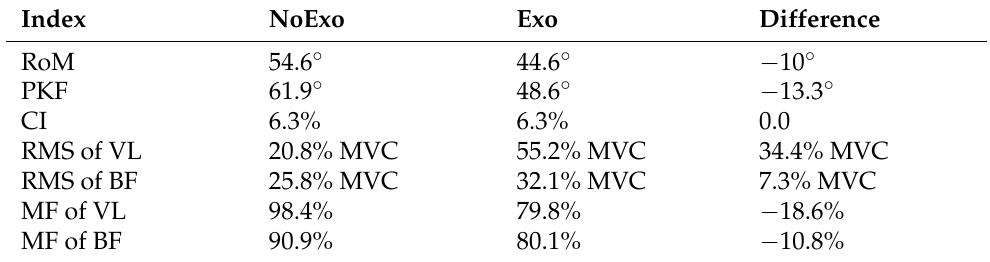
Table 1. Overall performance: comparison of modalities without the exoskeleton worn (NoExo) and with the resistive exosuit